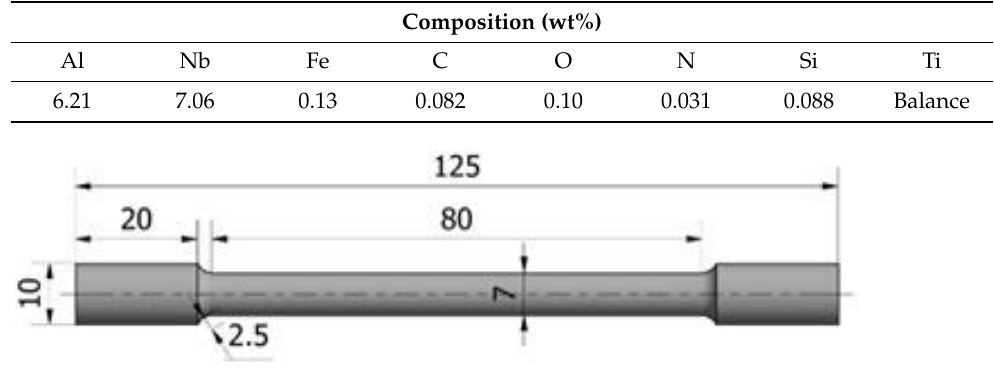
Figure 1. Dimension of tensile test specimens.